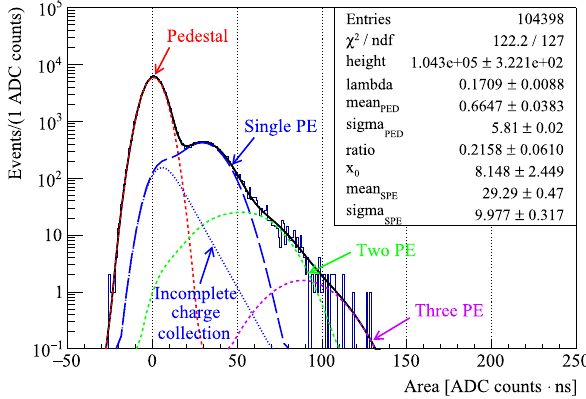
Fig. 5 Single-PE response of the top PMT in logarithmic scale single-PE spectra for the top and bottom PMTs are presented in Figs. 5 and 6, respectively.